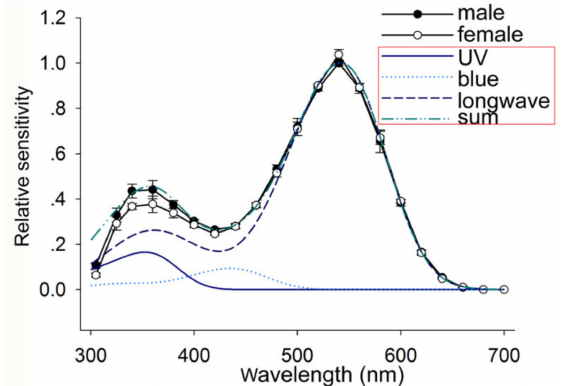
Figure 4. Spectral sensitivity curves of the compound eye of E. onukii measured with electroretinograms: The bidirectional recordings were typically repeated five times, yielding ten spectral scans. The open circles represent the spectral sensitivity of female adult leafhoppers, and the filled circles are that of males. The three blue fitting curves in the red frame represent the absorption spectra of putative visual pigments with peak wavelengths at 356 (UV), 435 (blue), and 542 (longwave) nm based on templates [32,33]. The dotted green color line in the red frame represents the absorption spectra of the summation of those three spectra at a ratio of 1:0.6:6.4 (UV / blue / green), normalized at 542 nm. UV, ultraviolet.